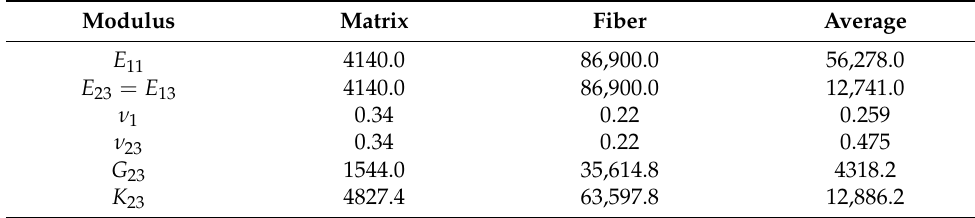
Table 4. Computed values of the elastic moduli (Case 2).